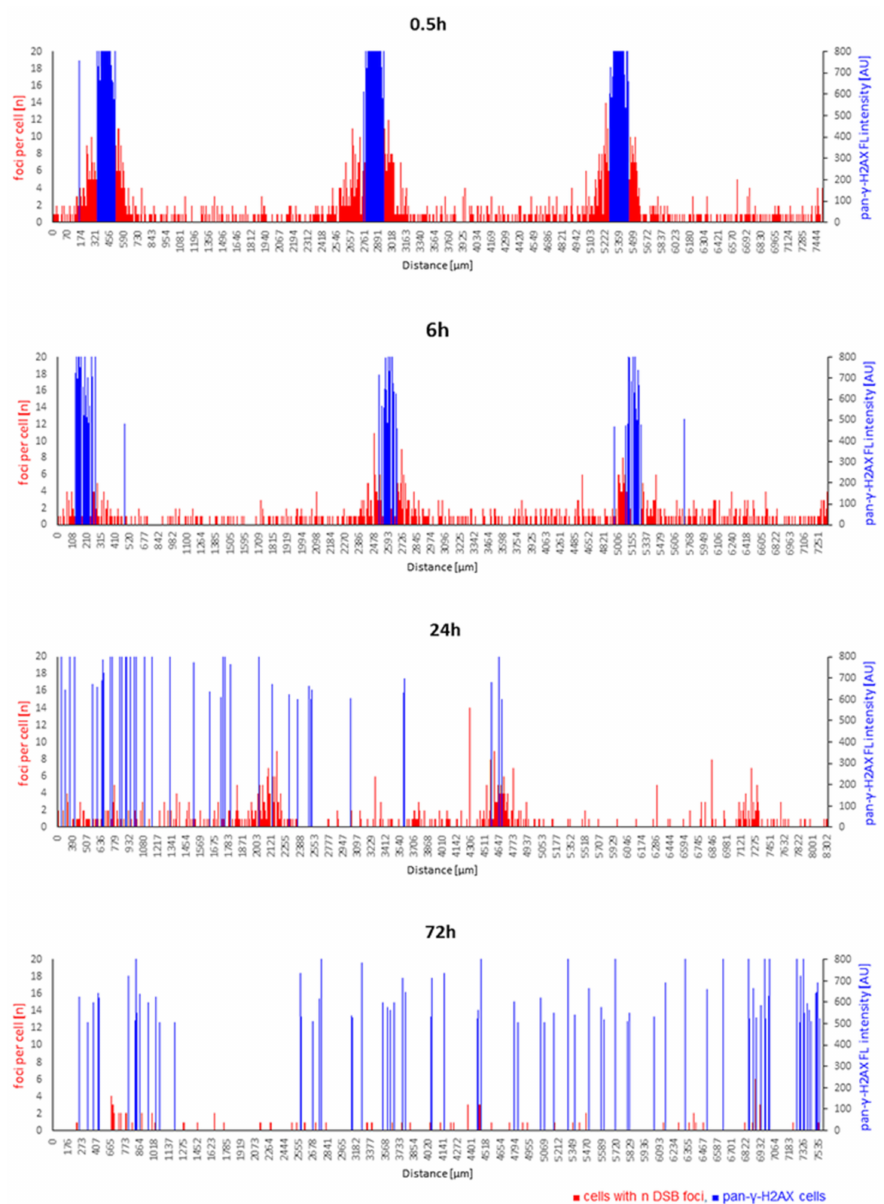
Figure 7. Time course of spatial DNA damage distribution and repair after 66 µ m pMBRT. Cells with n DSB foci per individual cell (red bars) along the length of the tissue cross-sections, with the height of each red bar corresponding to the number of foci within a spatially annotated cell nucleus. The height of the blue bars indicates the position of a pan- γ -H2AX cell nucleus and its fluorescence intensity (arbitrary intensity units, AU) along cross-sections. pMBRT of 66 µ m led to sharply localized damage at the dose peaks characterized by clustered pan- γ -H2AX cells (blue) flanked with cells showing elevated DSB foci numbers 0.5 and 6 h after irradiation. This spatial arrangement was absent at 24 h, while at 72 h of DNA repair, pan- γ -H2AX cells were scattered over the models. For comparison, a spatially annotated time course of sham-irradiated models is shown in Supplementary Figure